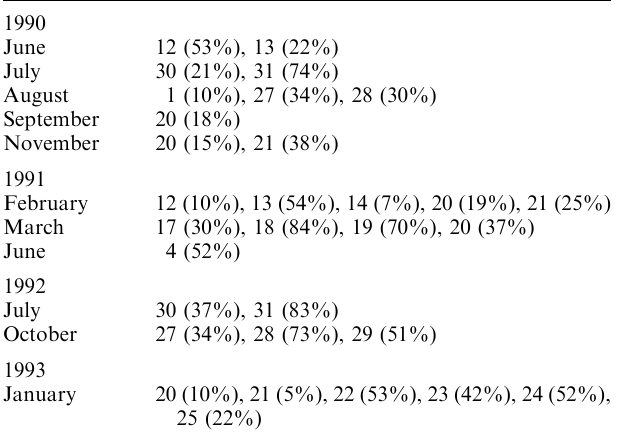
Table 1. Dates of EISCAT VHF Common Program 6 vertical wind data. The percentage of usable data points is indicated after each date